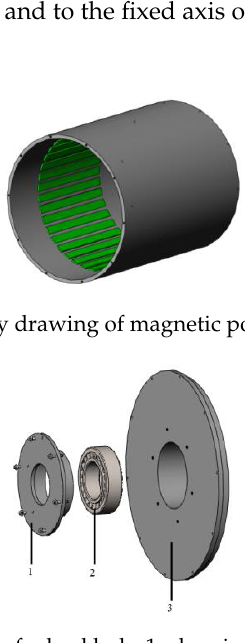
Figure 10. Assembly drawing of wheel hub. 1—bearing cap, 2—bearing, 3—end cap.